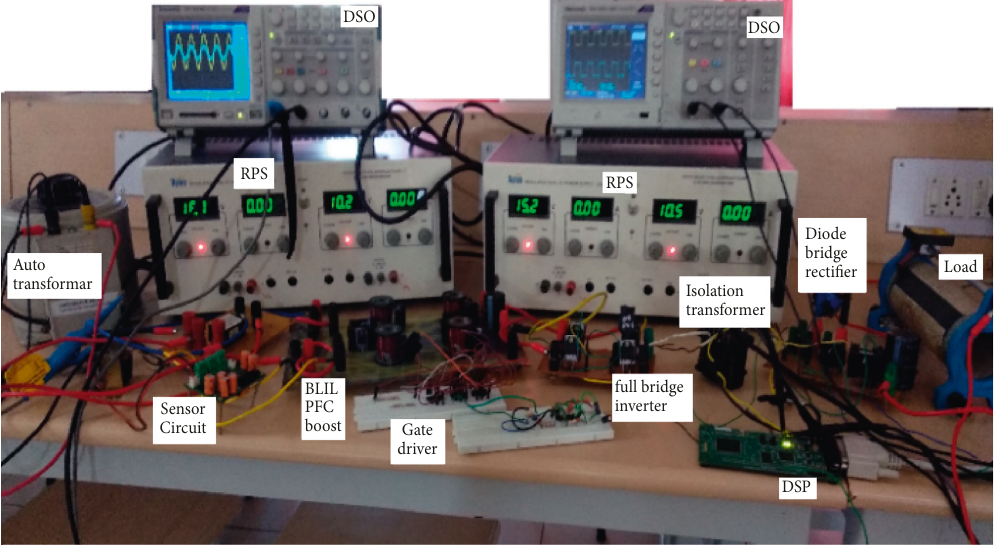
Figure 9: Experimental